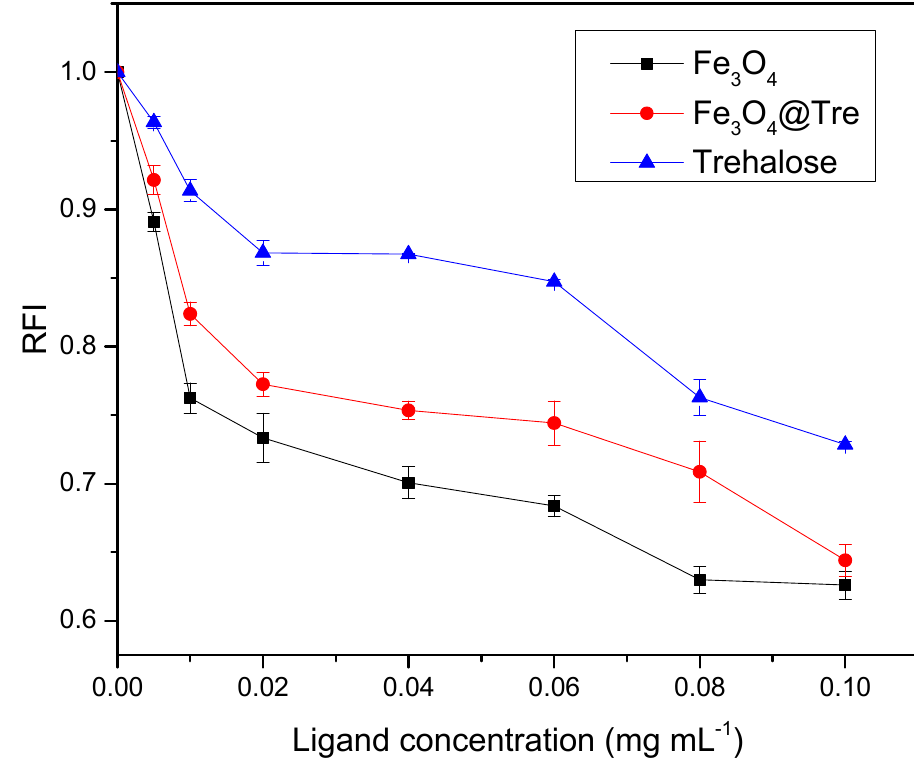
Figure 8. UV-Vis test evaluation of protein activity.